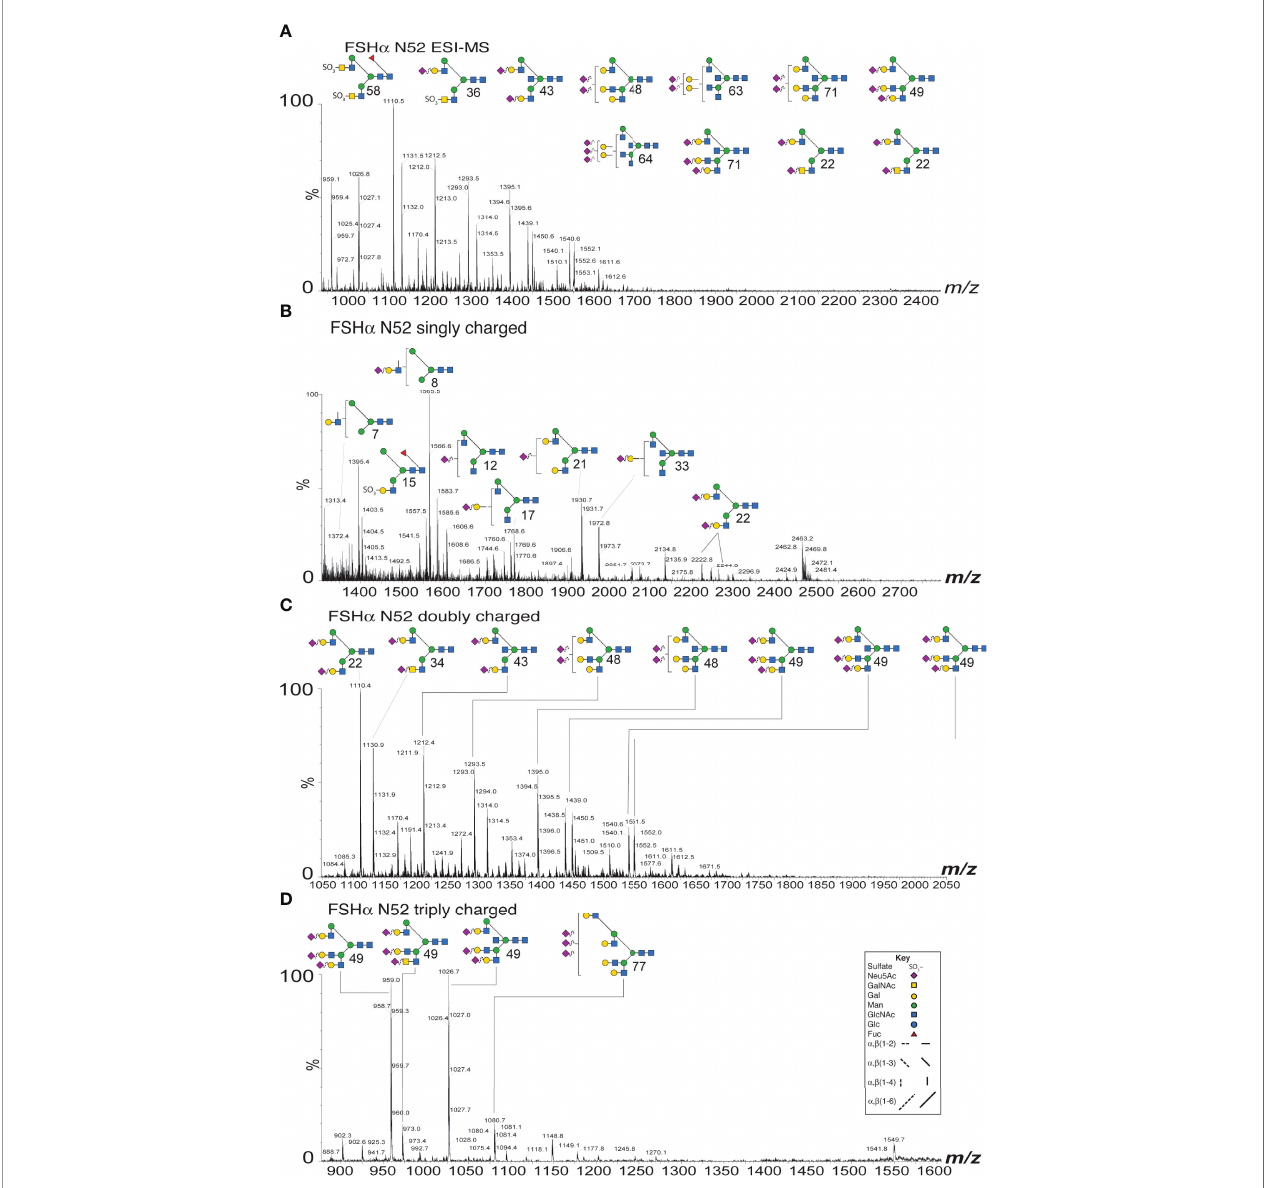
FIGURE 2 | ESI-MS and ion-mobility MS spectra for FSH a Asn 52 glycans. (A) Nano-ESI-MS spectrum. (B) Singly charged ion mobility MS spectrum. (C) Doubly charged ion mobility MS spectrum. (D) Triply charged ion mobility MS spectrum. Glycan structures displayed using the CFG/Oxford system, which identi fi es monosaccharides with colored symbols and linkages without the use of labels (see key). The glycan numbers correspond to Table 1